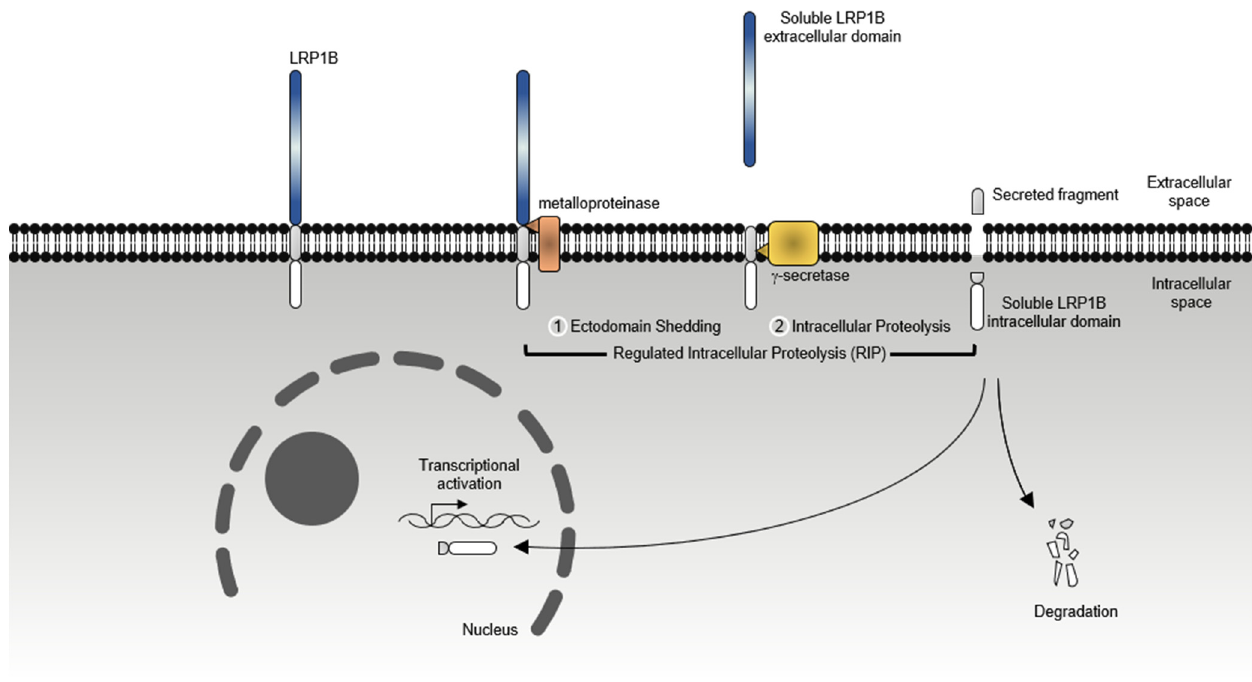
Figure 7. Regulated intramembrane proteolysis (RIP) of LRP1B. LRP1B undergoes proteolytic cleavage by a metallopro- teinase (i.e., ADAM17) that results in the shedding of its extracellular domain. Then, the remaining 21 kDa membrane-bound carboxyl-terminal fragment undergoes a gamma-dependent intramembrane cleavage that results in the release of the LRP1B intracellular domain (18 kDa) into the cytosol, where it can be degraded or translocated to the nucleus.